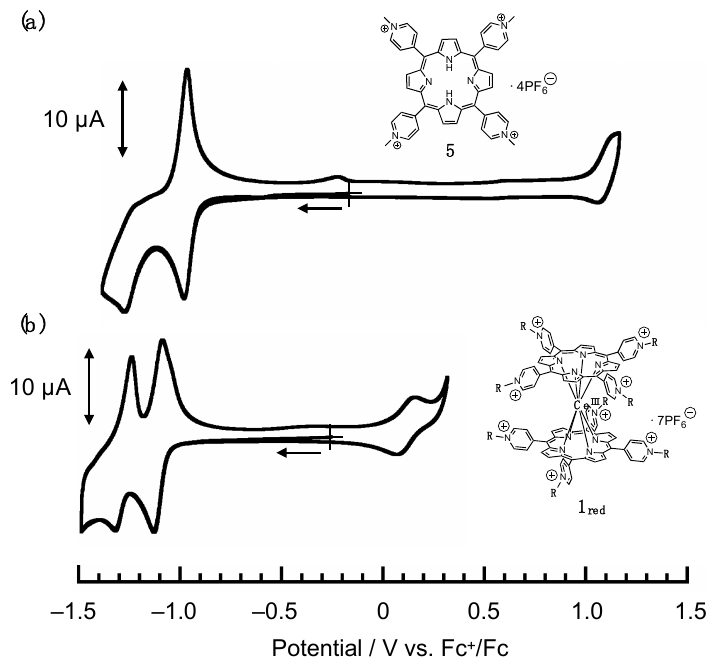
Figure 3. Cyclic voltammograms of ( a ) 5 and ( b ) 1 red in CH 3 CN solution containing 100 mM n Bu 4 NPF 6 . Measurements were performed at a scan rate of 100 mV/s at 20 °C; [Substrate] = 300 µ M.